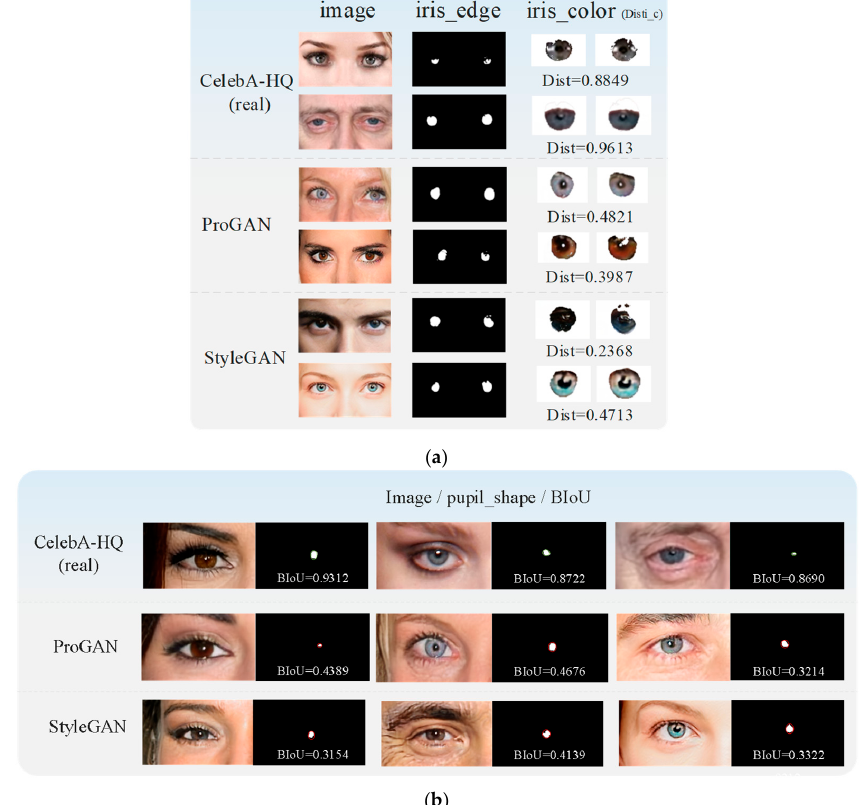
Figure 5. Example of ICD and PSE detection results. ( a ) the forgery images detected by the ICD. ( b ) the forgery images detected by the PSE.